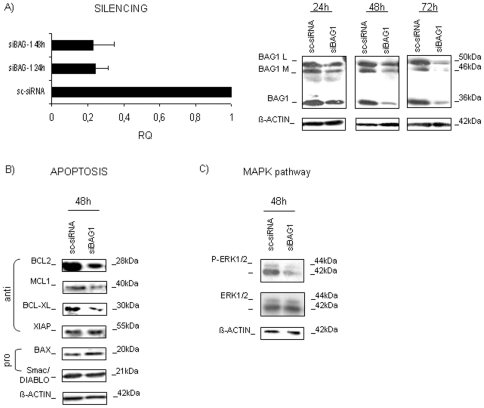
BAG1 silencing in the HL60 cell line.A) BAG1 mRNA and protein expression after silencing are shown. Histogram shows the relative quantification (RQ) of BAG1 mRNA expression compared to control sc-siRNA silenced HL60 cells (RQ = 1 in the figure; n = 4; **p<0.01). WB analysis confirmed that all three BAG1 protein isoforms were down-regulated after transfection with BAG1 specific siRNA. B) Analysis of pro- and anti-apoptotic proteins expression 48 h post-transfection. C) Expression of MAPK pathway-related proteins validated by WB, 48 h after siBAG1 or sc-siRNA transfection. β-ACTIN is shown as total protein loading control.